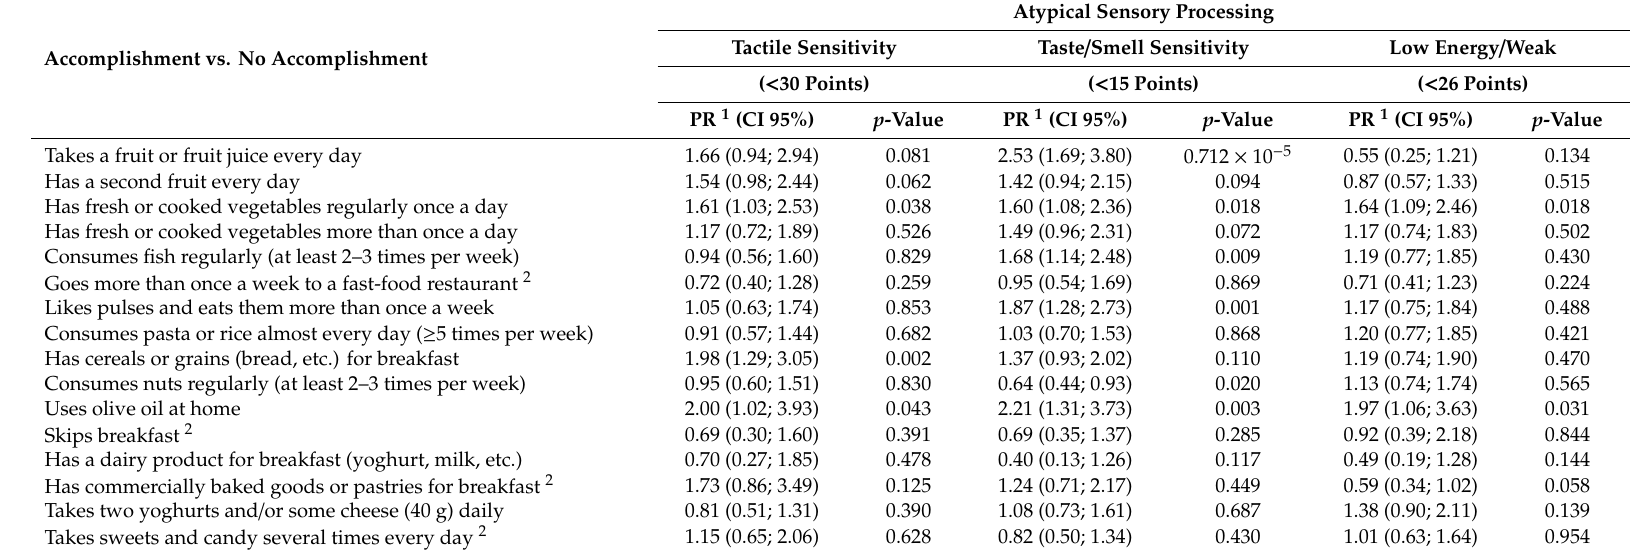
Table 3. Association between components of KIDMED index and atypical sensory processing in the SSP taste / smell sensitivity and low energy / weak subscales in children aged 3–7 years from the InProS Project, Alicante, Spain ( n =